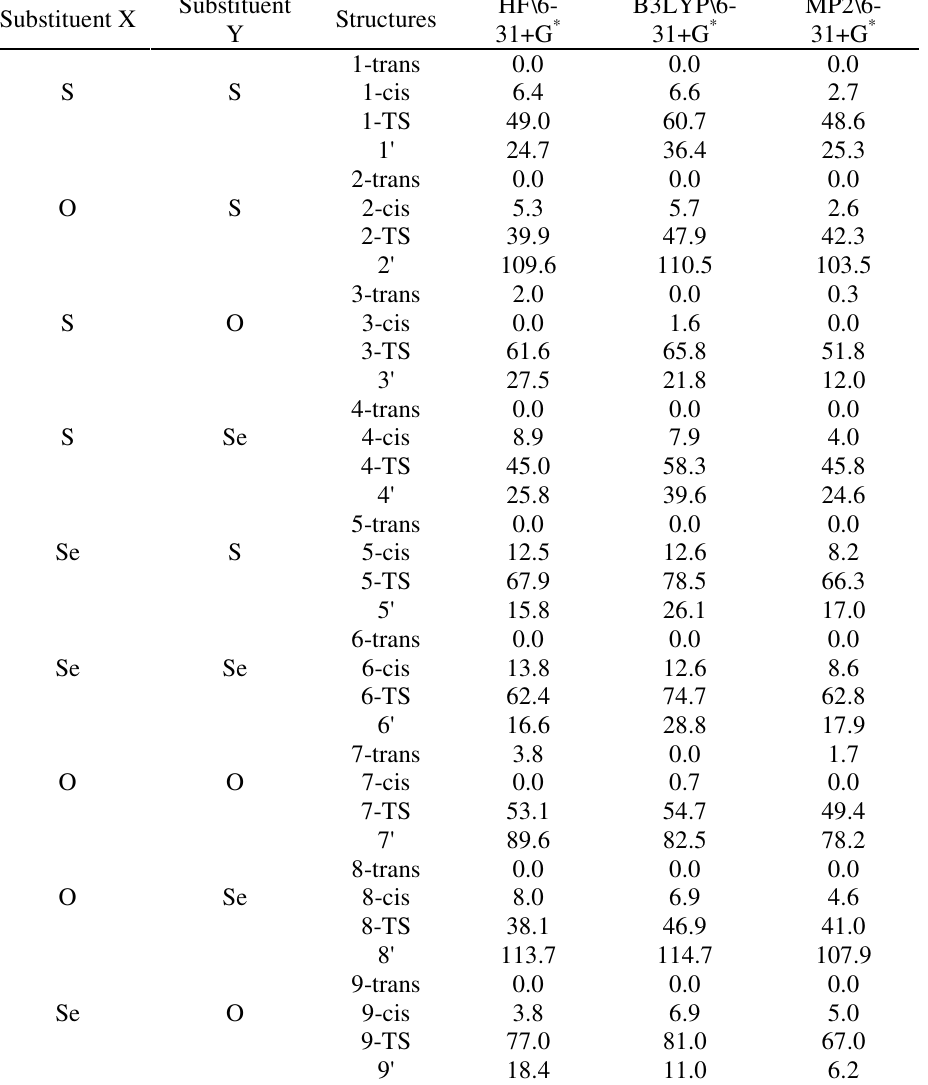
Table 2. Calculated relative energy (including zero-point energy, kJ mol -1 ) for 1-9 [X=CH- CH=C=Y (X and Y= O, S, and Se)] 1'-9', including linear and their own cyclic forms Substituent